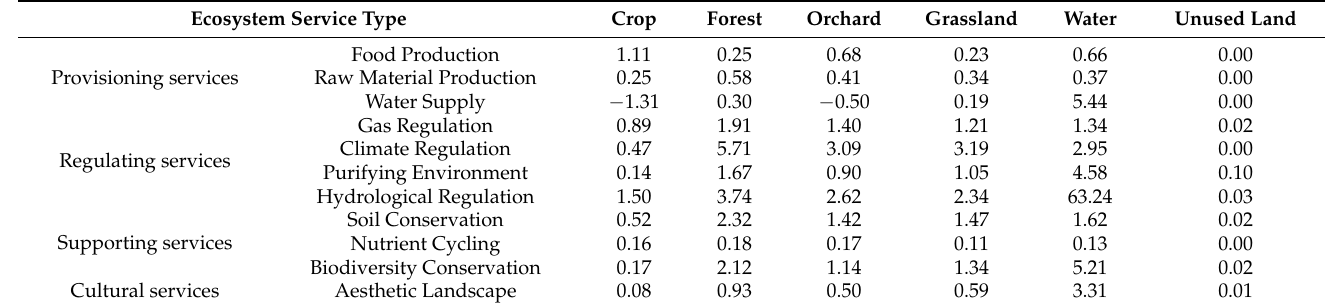
Table 3. Basic equivalent factor value of per unit area in Qianxi County.